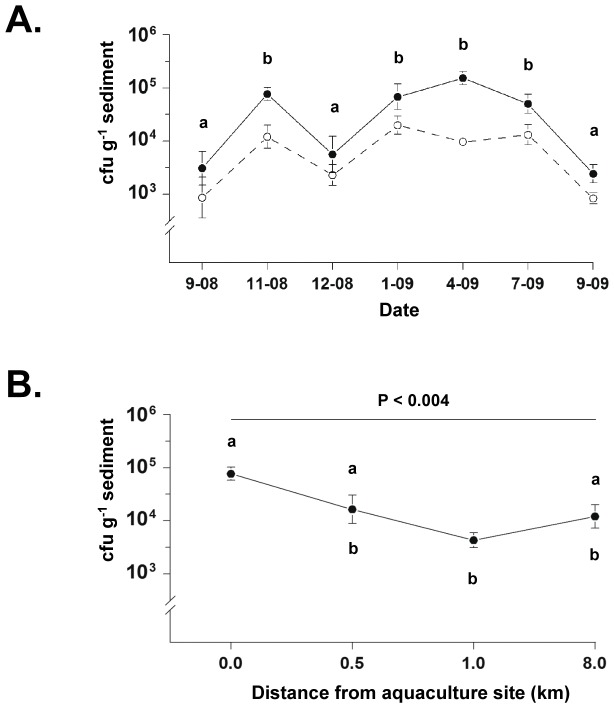
Culturable bacteria in sediment samples at aquaculture and control sites taken at various time points.A. Colony forming units (cfu) g−1 sediment (mean ± SE) in samples taken from September, 2008, to September, 2009, were significantly higher at the aquaculture site (closed circles) than at the control site (open circles) at all time points (P<0.001); different lower case letters indicate significant differences (P<0.05). A total of 66 samples were taken, 33 from the aquaculture site and 33 from the control site. B. Cfu g−1 sediment (mean ± SE) taken in November, 2008, at the aquaculture site (0.0 km) and at sites 0.5, 1.0 and 8.0 km (control site) distant from it. Aquaculture and control sites correspond to sites shown in Fig. 2A for this date; five samples were taken from each additional site studied. Different lower case letters indicate significant differences (P<0.05, see text for details of statistical analysis).